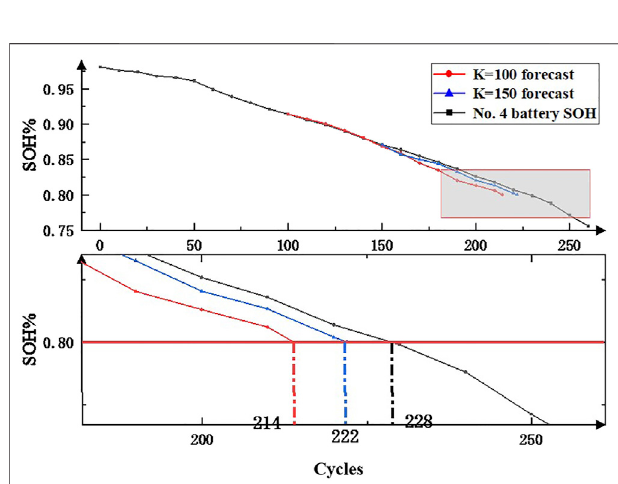
FIGURE 7 | Prediction results of the improved particle fi lter algorithm for No. 2 battery.